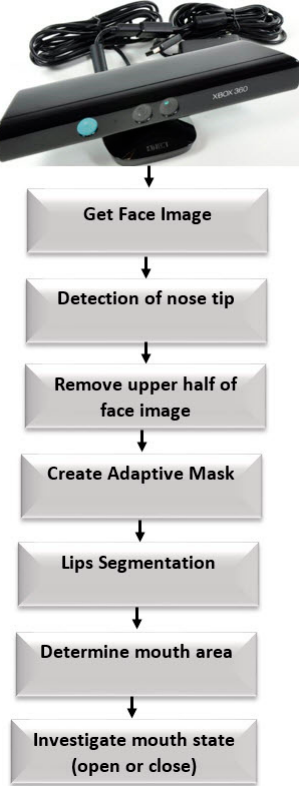
Figure 1. Block diagram of our